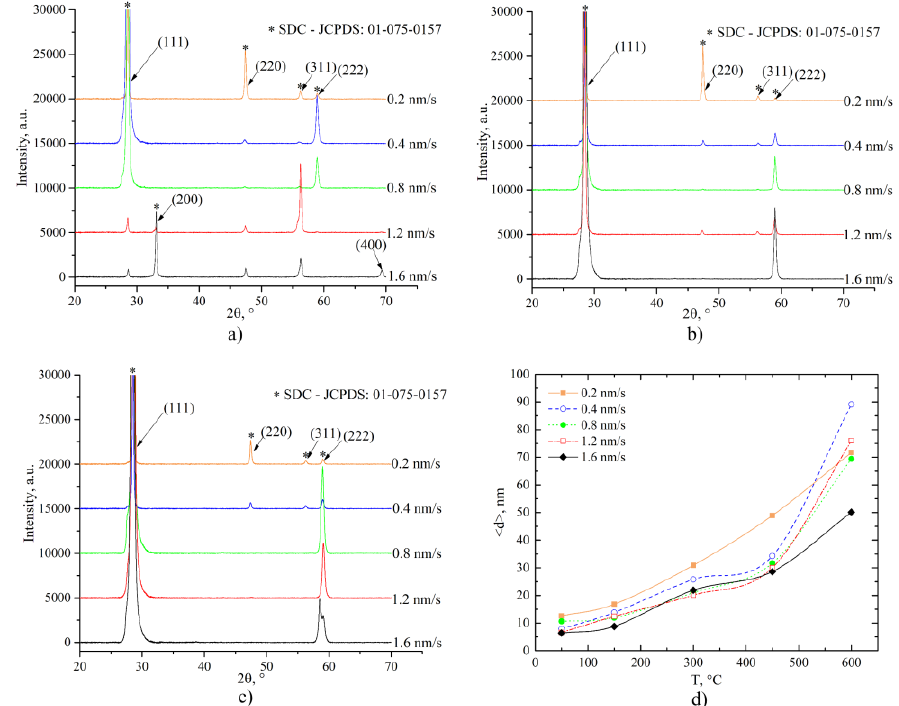
Figure 1. X-Ray Diffraction (XRD) measurements results: XRD patterns of thin Sm-doped cerium (SDC) films deposited on SiO 2 substrate (600 °C) evaporating powders of ( a ) 6.2 m 2 /g, ( b ) 11.3 m 2 /g, ( c ) 201.3 m 2 /g specific surface area, and ( d ) dependences of crystallite size on SiO 2 substrate temperature (11.3 m 2 /g powder).